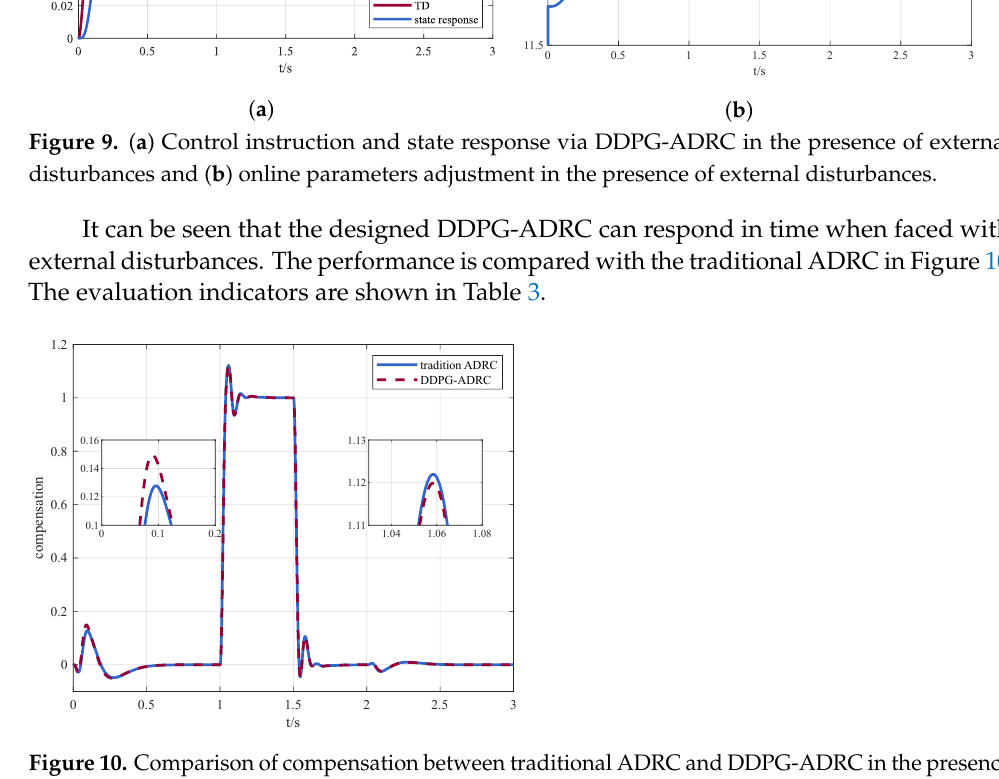
Figure 10. Comparison of compensation between traditional ADRC and DDPG-ADRC in the presence of external disturbances. Table 3. Evaluation indicators of traditional ADRC and DDPG-ADRC in the presence of disturbances. Evaluation